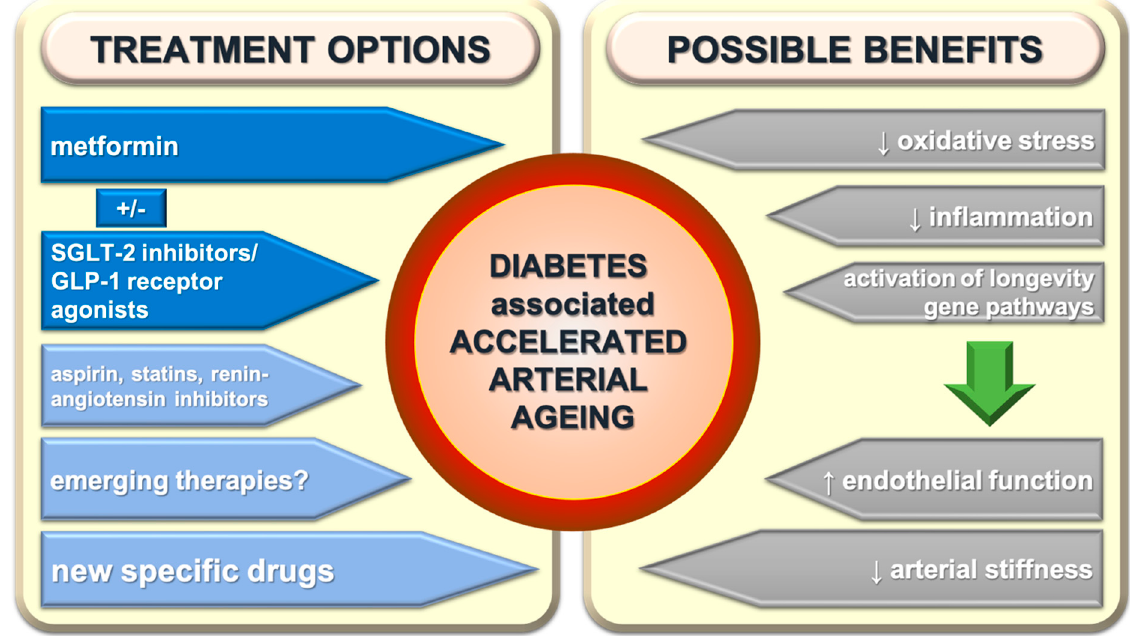
Figure 3. Treatment possibilities of diabetes-associated accelerated arterial ageing and its effects. SGLT-2—sodium-glucose cotransporter-2; GLP-1—glucagon like peptide-1.